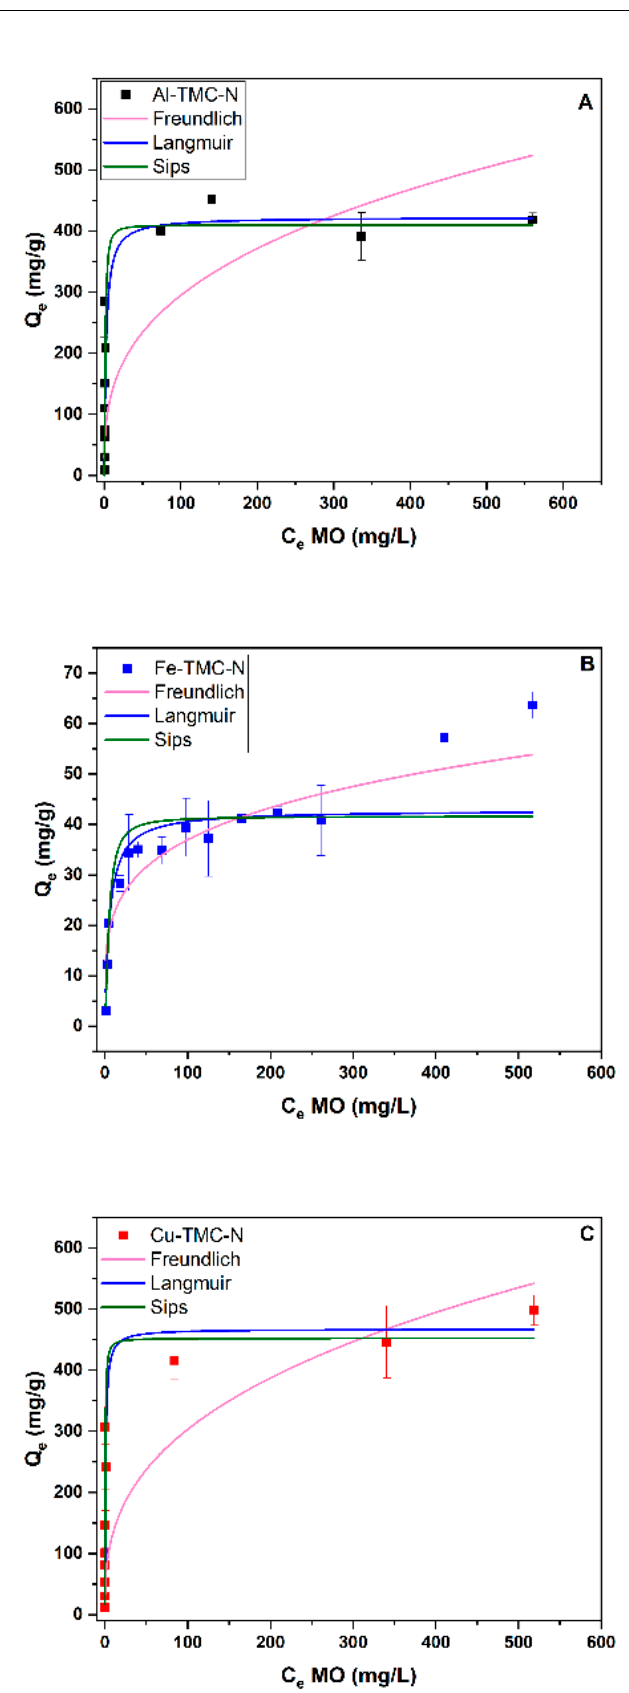
Figure 7. Methyl Orange adsorption profiles and best-fits by various models (Freundlich, Langmuir, and Sips) for the TMC materials: Al-TMC-N ( A ), Fe-TMC-N ( B ), Cu-TMC-N ( C ).